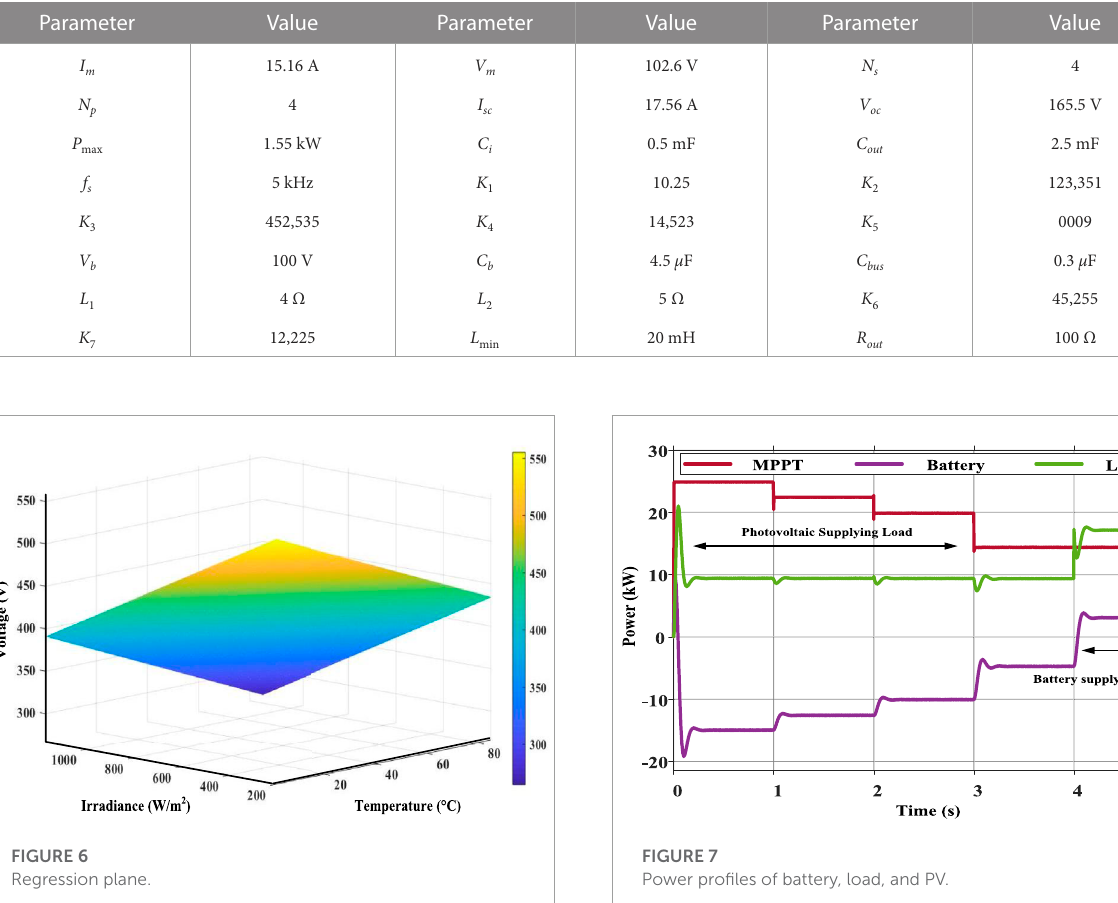
TABLE2 Systemparametersandinitialconditions.